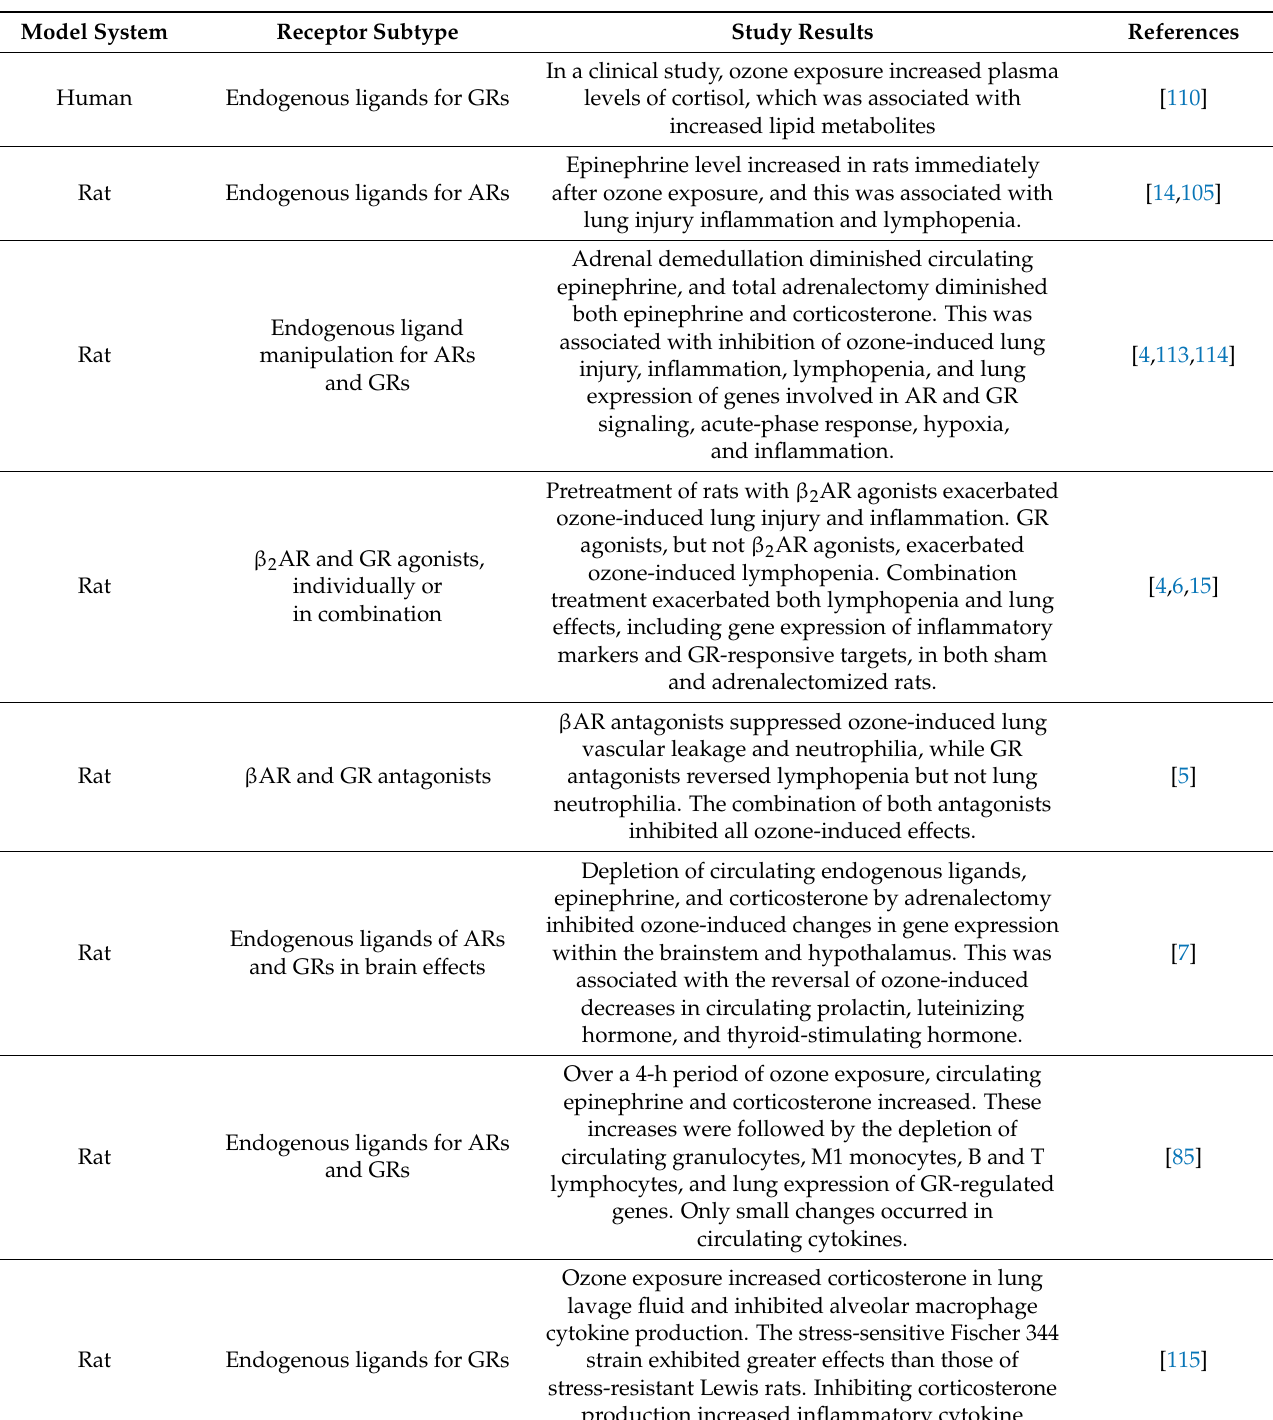
Table 3. Selected experimental studies involving ozone and the roles of adrenergic receptor (AR) and glucocorticoid receptor (GR) subtypes and/or their endogenous ligands—catecholamines and glucocorticoids, respectively. This table is not meant to be a comprehensive list of all experimental studies that mention ARs and/or GRs; rather, ozone studies focused on the lungs and addressing the roles of ARs and GRs and their endogenous ligands are